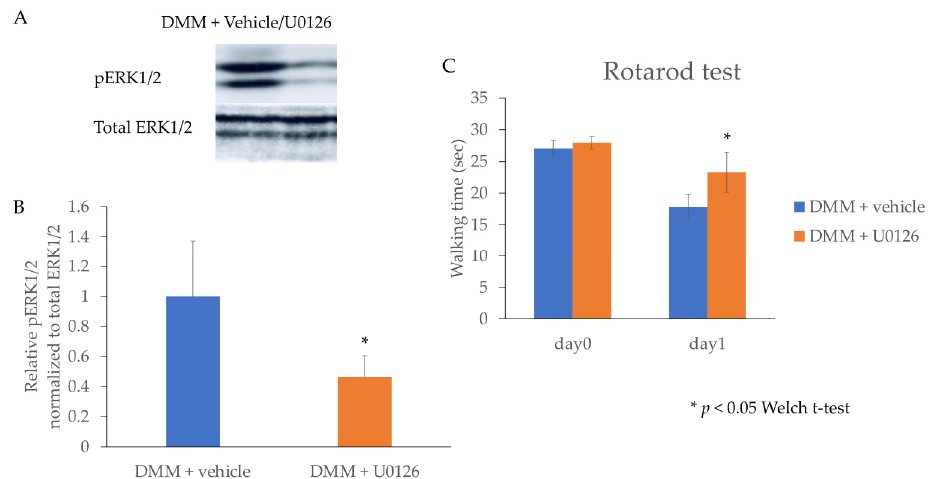
Figure 6. Expression of pERK1/2 and the rotarod performance test after the intrathecal injection of the MEK inhibitor U0126. ( A ) Immunoblot images of pERK1/2 and total ERK1/2 in the right dorsal horn of the spinal cord 1 day after surgery. ( B ) The quantified data of the immunoblot for pERK1/2 normalized to total ERK1/2. Each n = 5, * p < 0.05. ( C ) Walking time in the rotarod performance test. Each n = 5, * p < 0.05. All data are presented as mean ± standard deviation. pERK, phosphorylated extracellular signal-regulated kinase; DMM, destabilization of the medial meniscus.